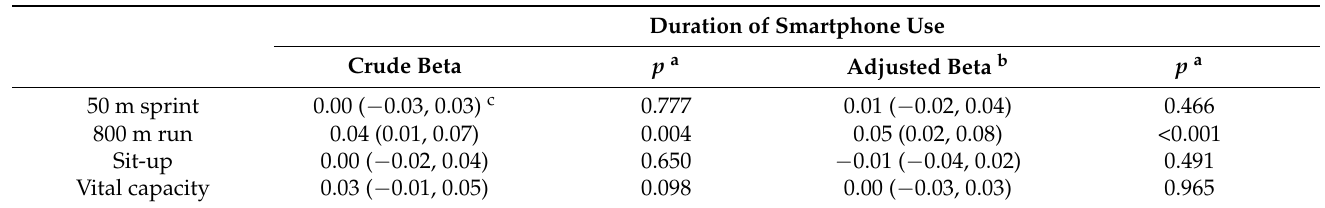
Table 4. Association between duration of smartphone use and physical fitness in 4472